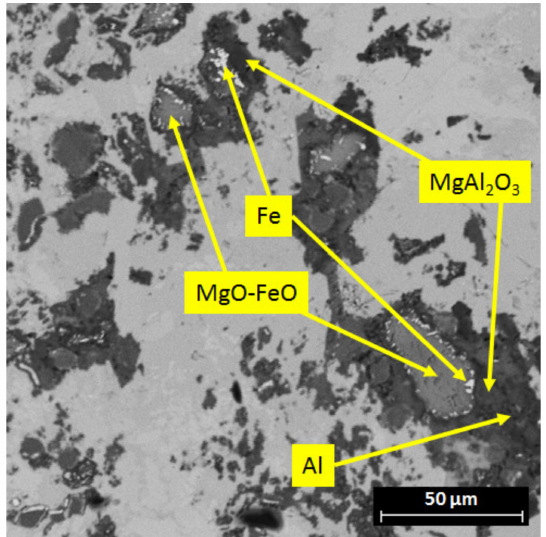
Figure 13. SEM micrograph of the C_850 sample with decomposition of the MgO-FeO solid solution to MgAl 2 O 4 and